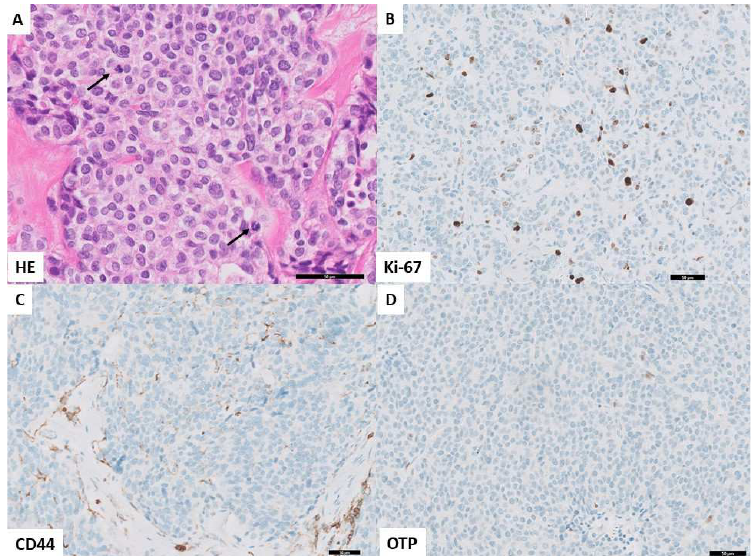
Figure 5. Unfavorable profile in histology and immunohistochemistry. ( A ). HE (40×) showing carcinoid with a mitotic hotspot with readily visible two mitotic figures in one HPF (arrows). ( B ). Immunohistochemistry for Ki-67 (20×) showing a proliferation index of >5% in tumor cells. ( C ). Immunohistochemistry for CD44 (20×) showing loss of cytoplasmatic and membranous staining in the tumor cells ( D ). Immunohistochemistry for OTP (20×) showing loss of nuclear staining in the tumor cells.